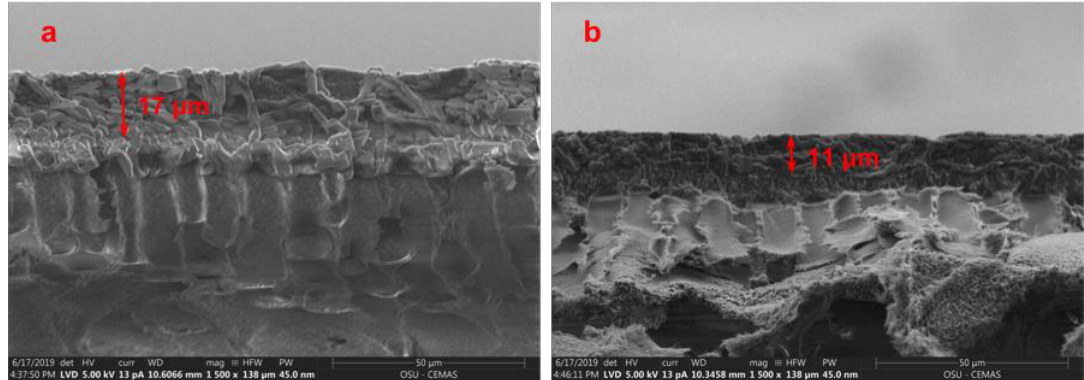
Figure 10. Cross-sectional SEM images of membrane without AF-MWNTs ( a ) before and ( b ) after the 100-h test at 1.5 MPa.